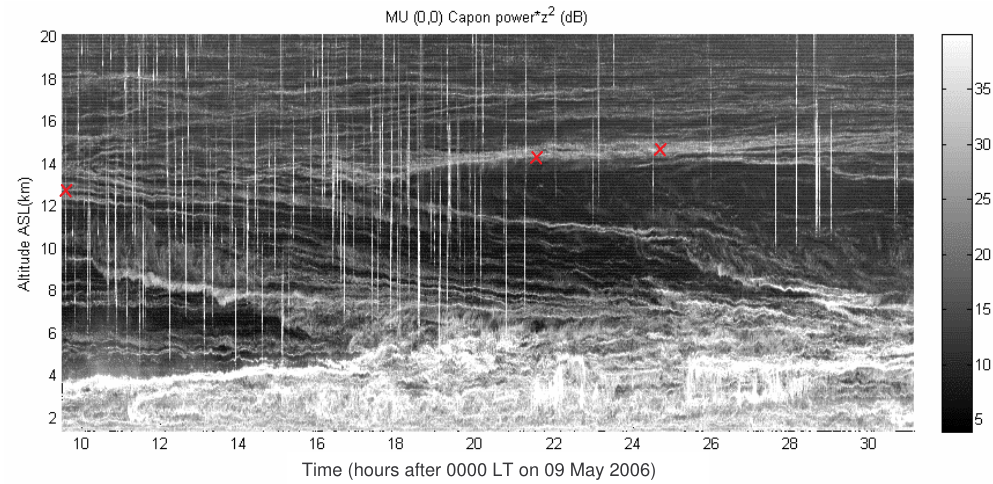
Fig. 2. Example of time-height plots of power after Capon processing, compensated by the range attenuation effects at a time sampling of 20.48s and a vertical sampling of 5m from 1.225km to 19.975km and from 9 May 2006 at 09:30 LT until 10 May 2006 at 07:07 LT. The red crosses indicate the tropopause height inferred from B4, B5 and B6. Vertical bright lines correspond to airplane echoes and should not be